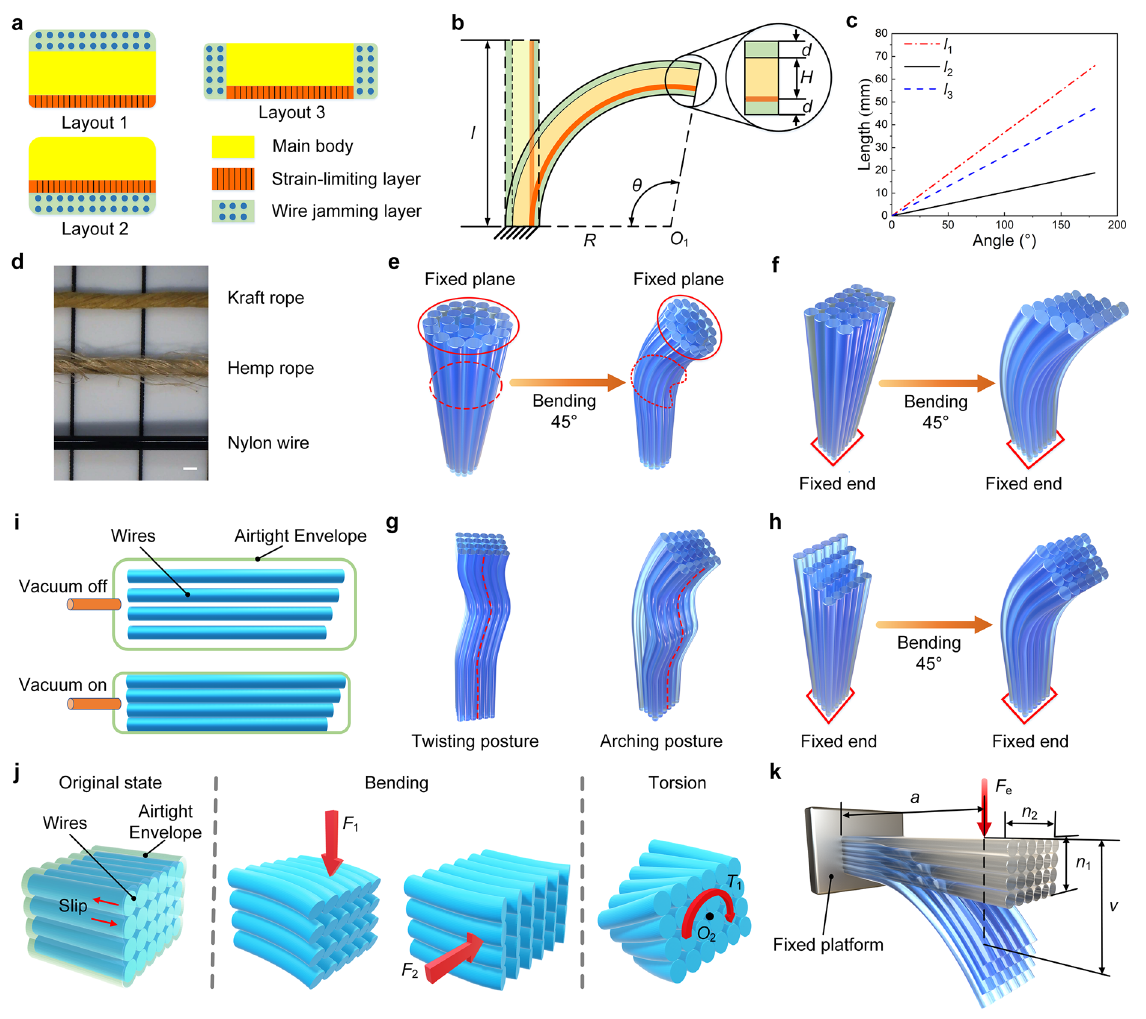
Figure 2. Design and analysis of Wire jamming structures. ( a ) Installation methods for wire jamming structures. ( b , c ) Illustration of wire jamming structures under bending state, where d , H , l , θ , R are jamming structure thickness, actuator thickness, actuator length, bending angle and bending radius, respectively. l 1 , l 2 , l 3 are the maximum stretch or compression length after bending for layout 1, lay- out 2, layout 3, respectively. ( d ) Demonstration of kraft rope (one-strand twisted kraft paper), hemp rope (two-strand twisted rope) and nylon wire (PA6, Alead Rubber & Plastic Products Co. Ltd., Hangzhou, China). Scale bar is 1 mm. ( e , f ) Presentation of jamming arrangements of circular cross- section and rectangular cross-section. ( g ) Two localized postures (twisting and arching) should be avoided. ( h ) The trimmed free end weakens the gradient effect after bending. ( i ) Schematic opera- tion principle of the wire jamming structure. ( j ) Three main types of external forces. ( k ) Illustration of the bending state of the wire jamming structure under applied force F e . During the bending motion, another problem is also presented, seen in Figure 2f. Due to the difference in bending radius, a gradient effect appears at the free end of the wires. As expected, the membrane wrapped around the outside of the wires also shrinks with the bending, in which the wires show an elongation-like phenomenon. When the wires reach the top of the membrane, localized twisting or arching is inevitable (Figure 2g), lead- ing to irreversible deformation. Therefore, the internal length of the envelope should be slightly larger than the length of the wires. A more effective method is to trim the wires at the free end in reverse gradient, which does not require a large space inside the enve- lope. As shown in Figure 2h, the trimmed wires weaken the gradient effect after bending. Based on the above analysis, we choose the rectangular cross-section as the final wire